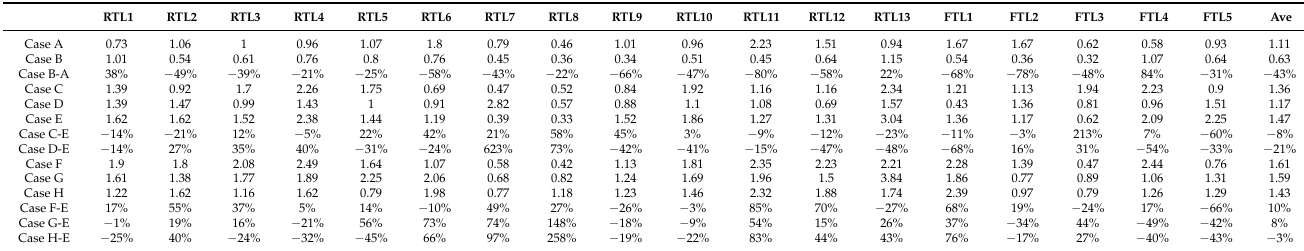
Table A2. Wind speed of all test streets and average value.